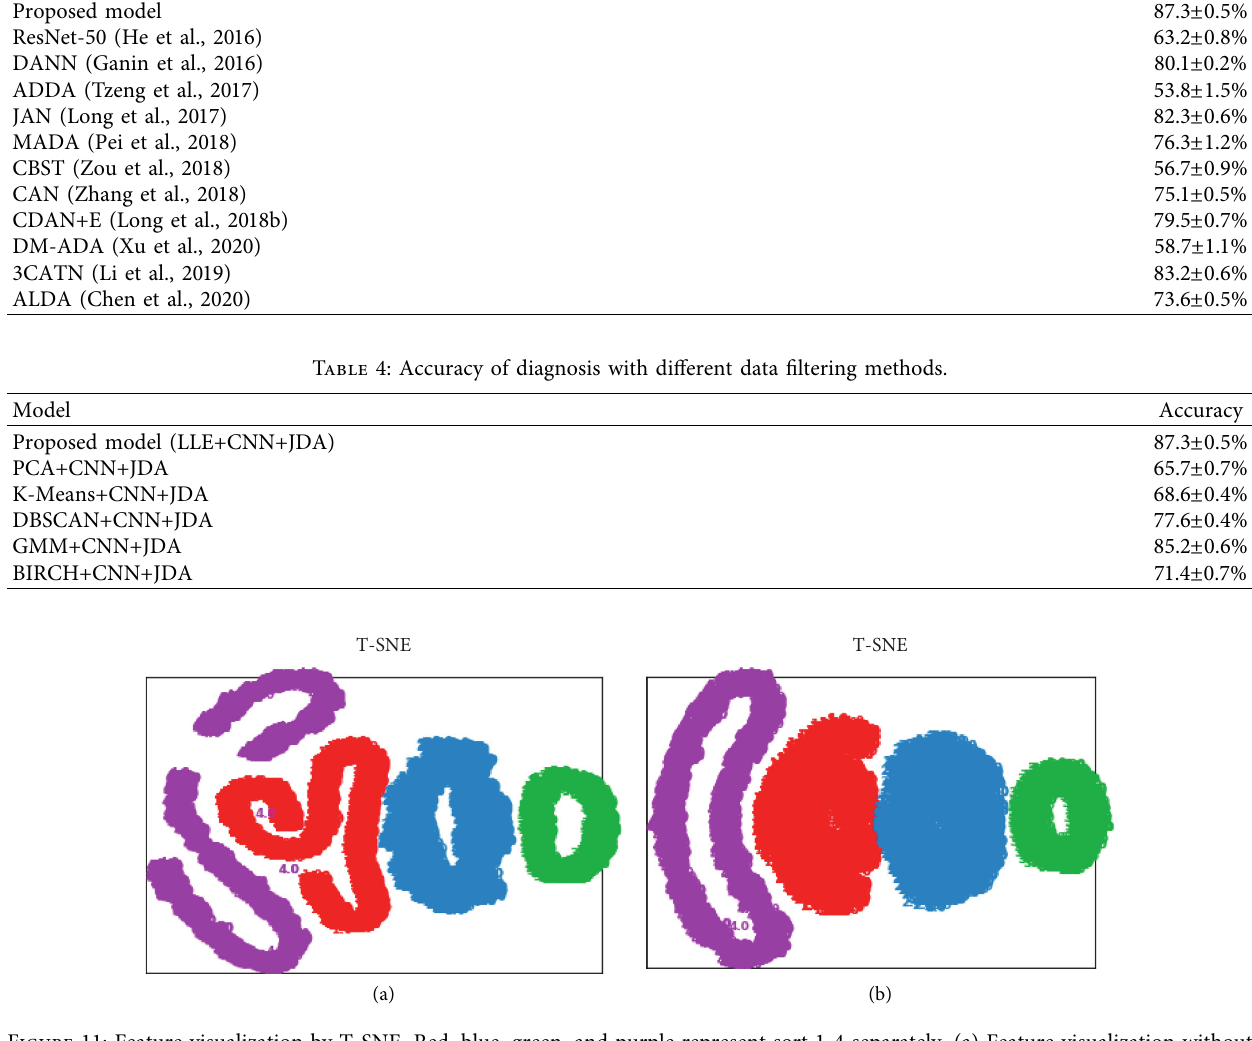
Figure 11: Feature visualization by T-SNE. Red, blue, green, and purple represent sort 1-4 separately. (a) Feature visualization without transfer learning; (b) Feature visualization after transfer